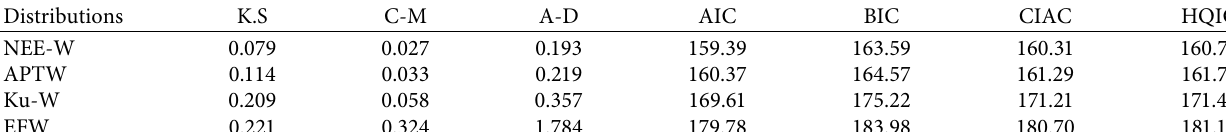
Table 6: The results of the goodness of fit and other analytical measures for the Netherland’s data. Distributions